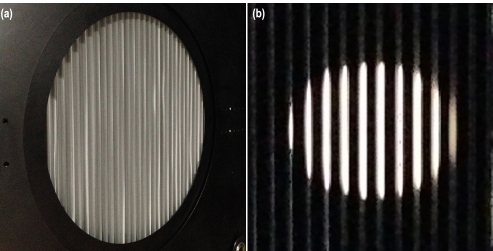
Figure 4. Non-uniformity of the sample exposed in grazing light ( a ); Measured area ( sampling aperture illuminated by the collimated beam from the light source) for θ i = 35 ◦ ( b ).